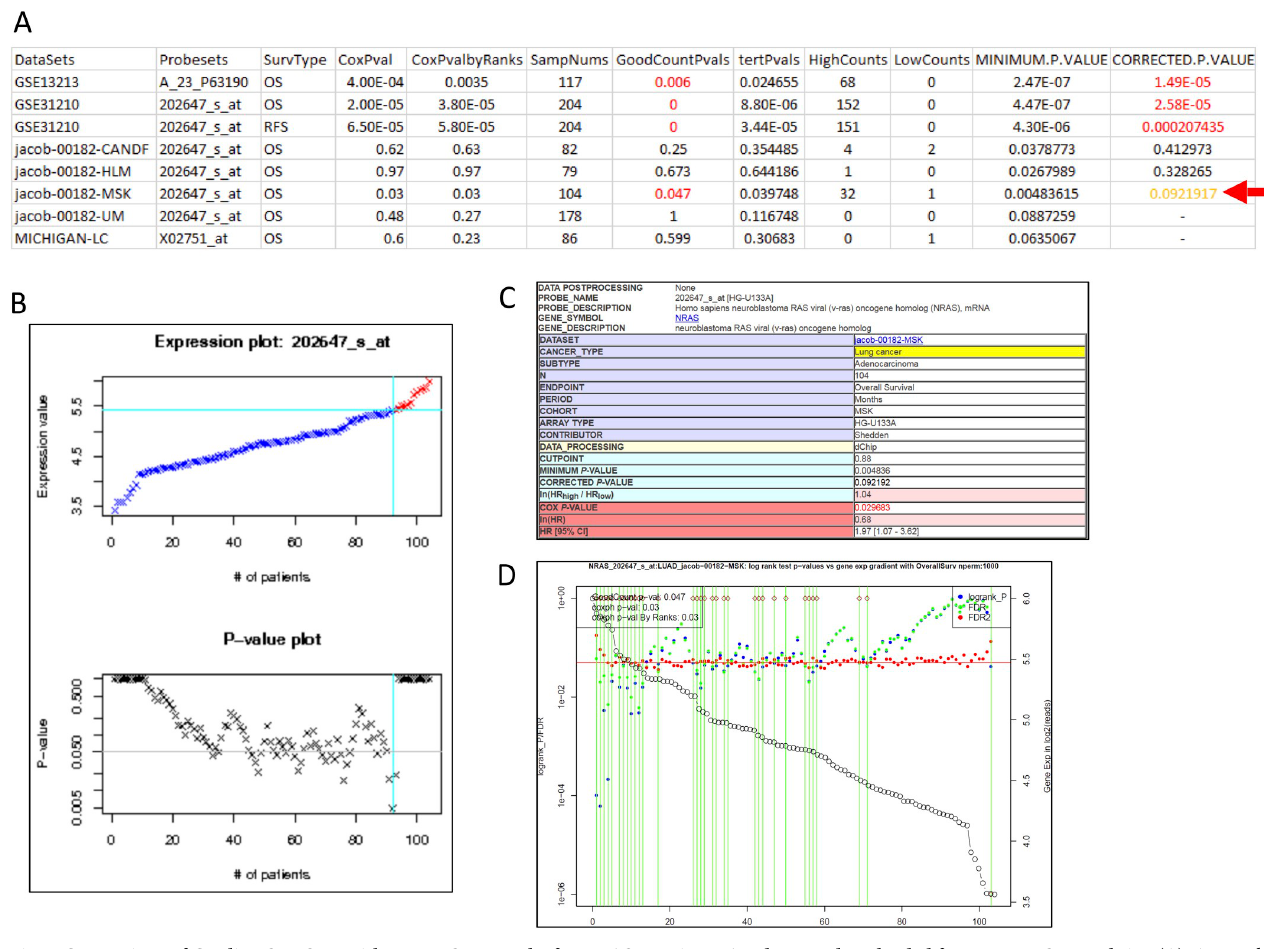
Fig 2. Comparison of GradientScanSurv with PrognoScan results for NRAS gene in LUAD datasets downloaded from PrognoScan website. (A). A joined table of GradientScanSurv results and direct results from the PrognoScan website for the NRAS gene in LUAD (lung adenocarcinoma) datasets from the PrognoScan website. The red arrow indicates a dataset where GradientScanSurv called a significant association with GoodCountPval = 0.047, but PrognoScan missed the call with CORRECTED.P.VALUE = 0.092. (B). Screenshot of PrognoScan’s expression gradient-based logrank p-values plot. The blue vertical line indicates where the minimal p-value is that was used for the final CORRECTED.P.VALUE. (C). Screenshot of the PrognoScan report with final CORRECTED. P.VALUE at 0.092. (D). GradientScanSurv gene expression gradient-based logrank p-values plot with GoodCountPval at 0.047. The green vertical lines indicate specific cut-points where the corresponding logrank p-values are significant at p-value < = 0.05. Univariant expression-based coxph p-value and expression- rank based coxph p-value are also reported here as in panel A. This result was consistent with the TCGA validation result in GoodCountPval (0.001). The plot of the results also illustrates that higher expression of NRAS is associated with faster death, which is indicated by the brown diamonds along the top part of the plots (Figure E in S1 File).